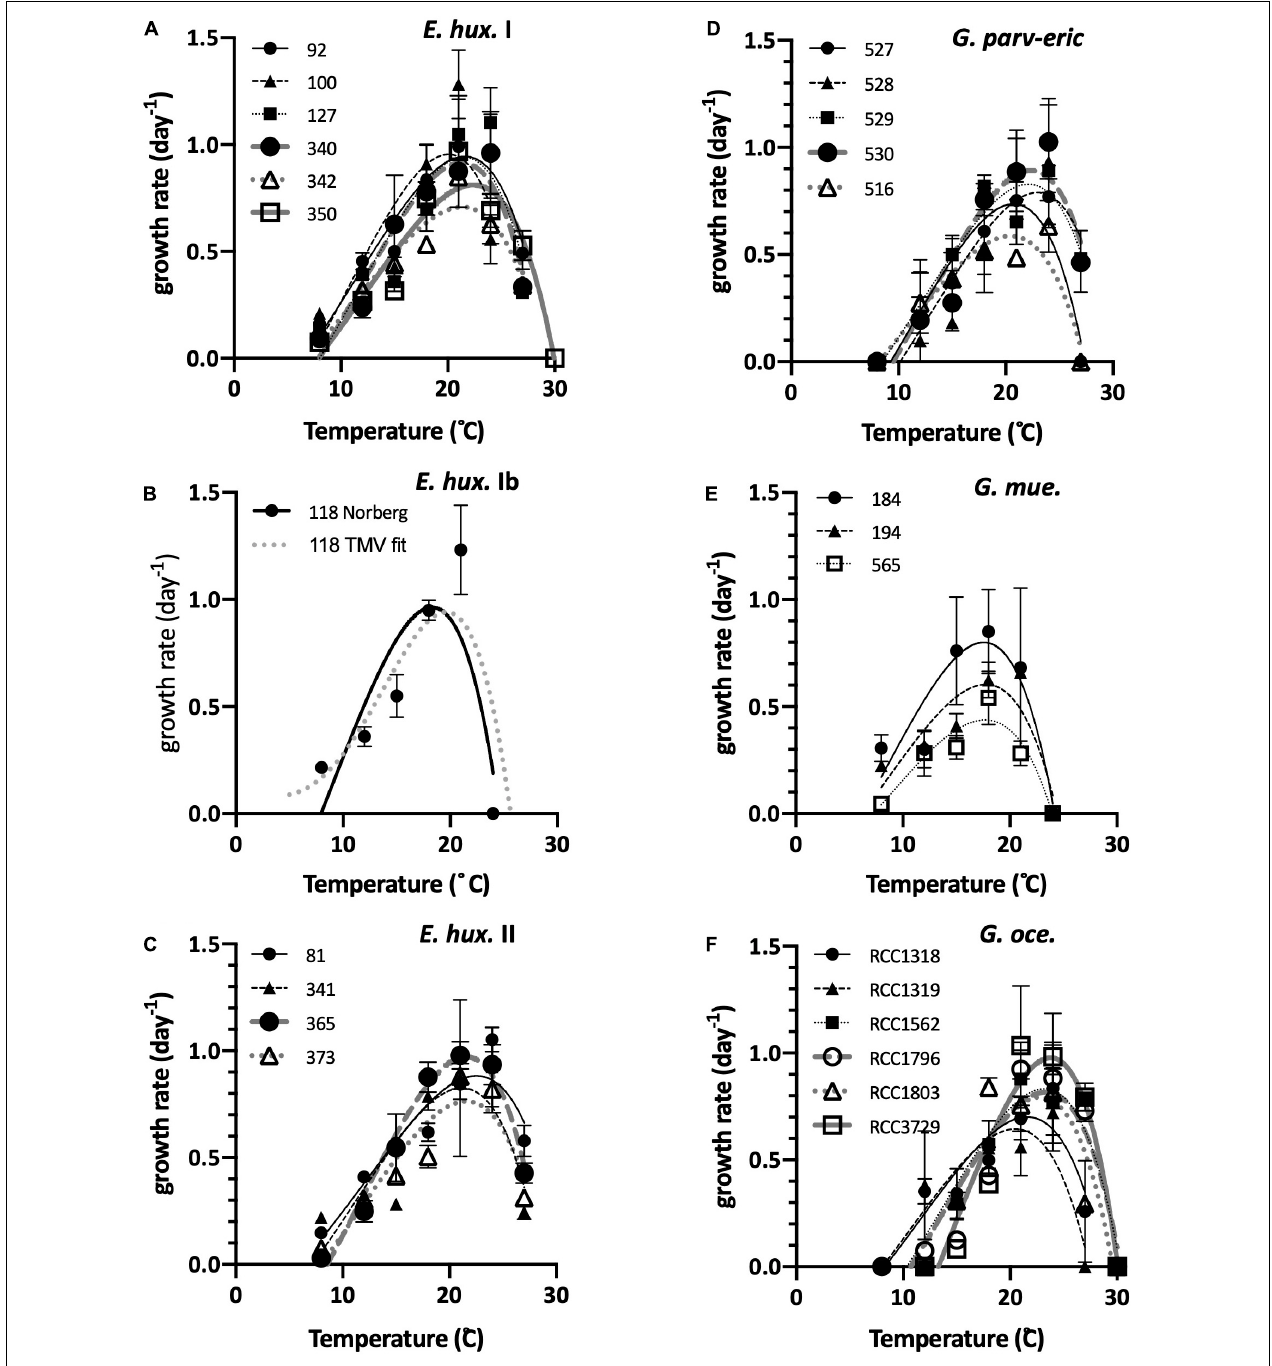
FIGURE 5 | Thermal performance curves for growth for all strains in Experiment 1, with the corresponding fits to the Norberg equation overlaid. (A) E. huxleyi haplogroup I. (B) E. huxleyi haplogroup Ib. Here, both the Norberg and TMV fit are shown for comparison. (C) E. huxleyi haplogroup II. (D) The 4 G. parvula (527–530) and 1 G. ericsonii (516) strains. (E) G. muellerae strains. (F) G. oceanica